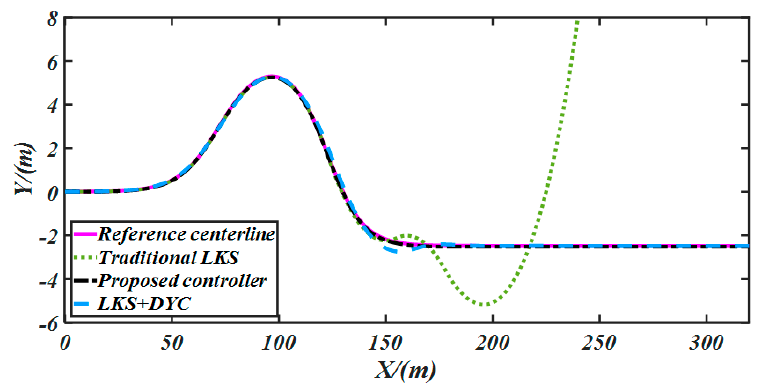
Figure 11. Trajectories controlled by three